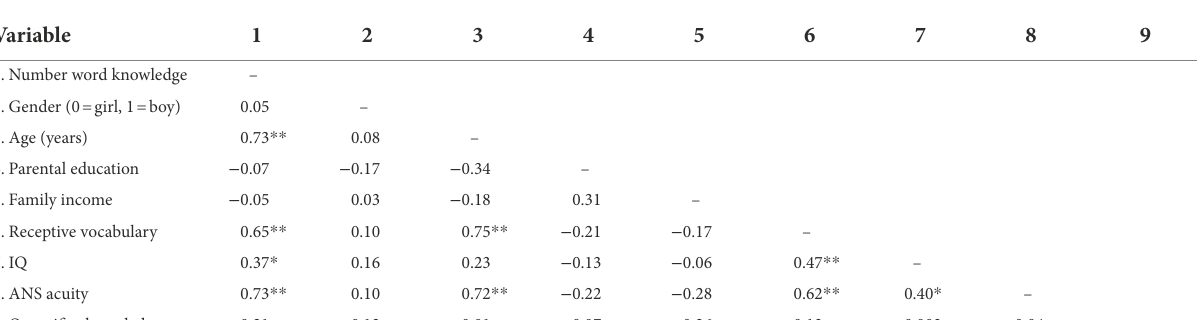
TABLE 5 Intercorrelations among the study